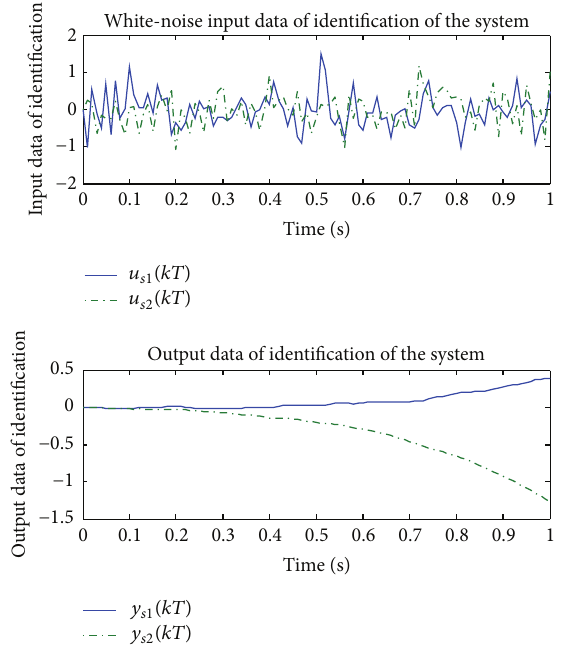
Figure 5: System I/O data for